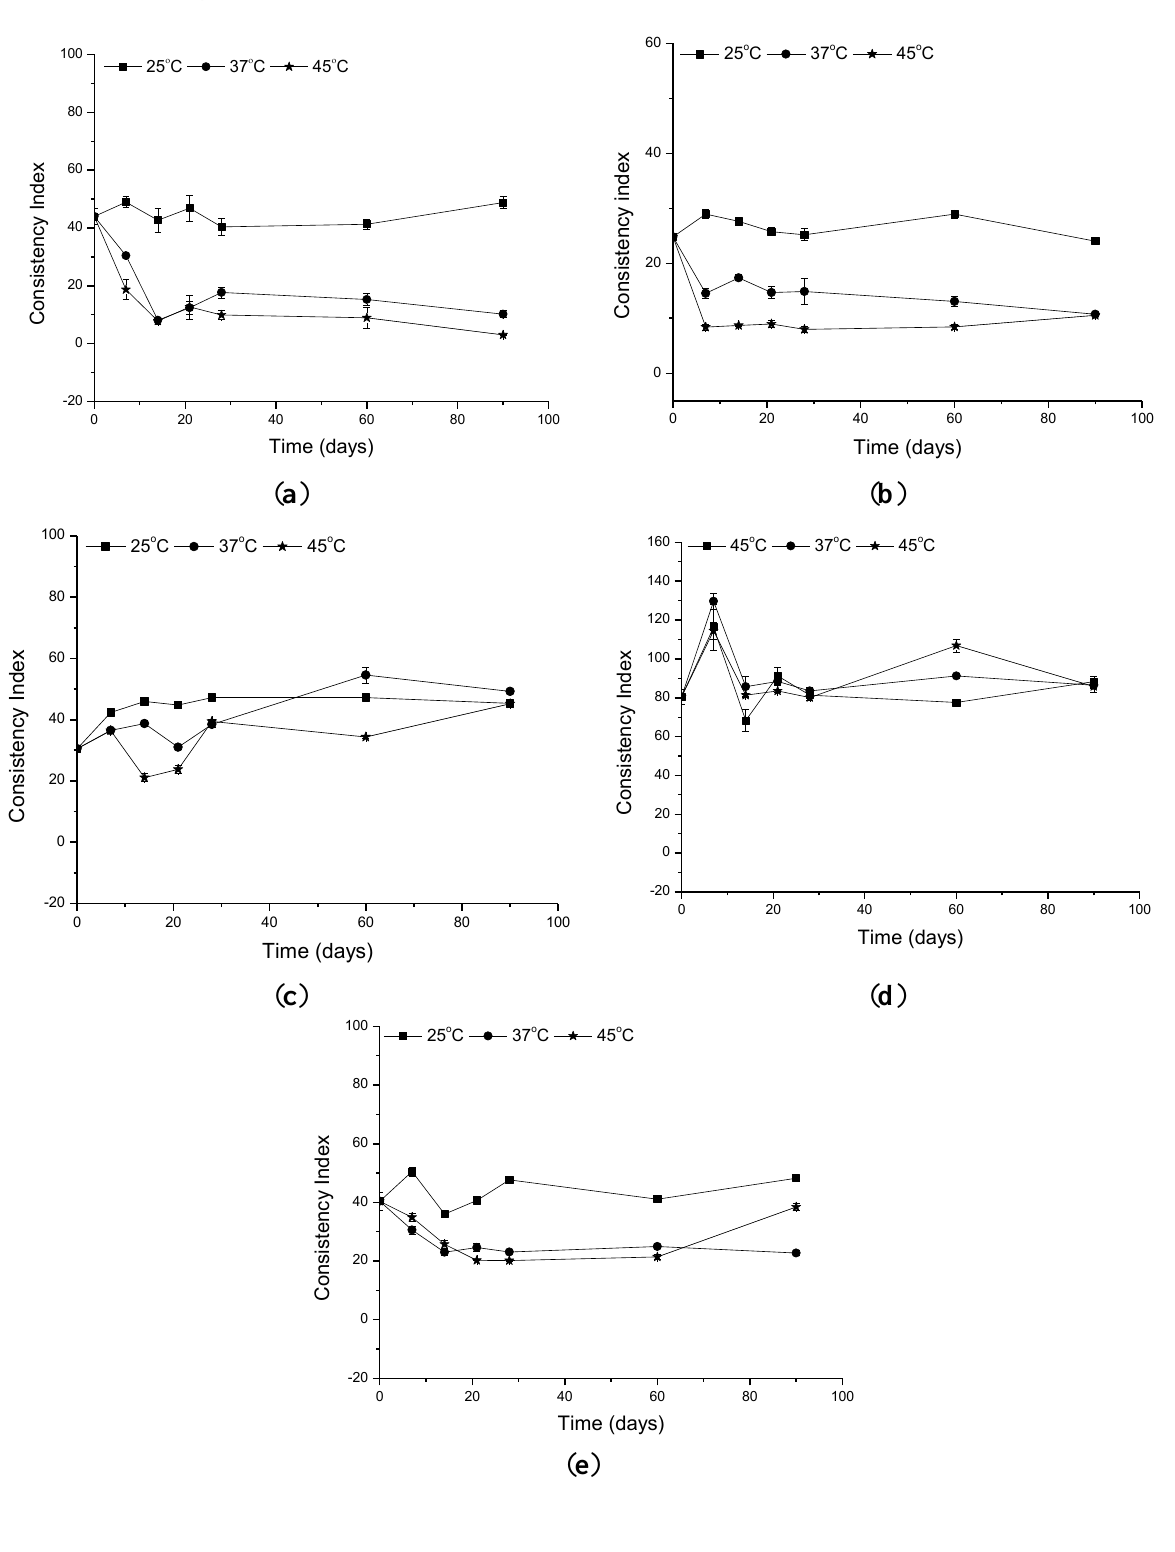
( d ) formulation 4